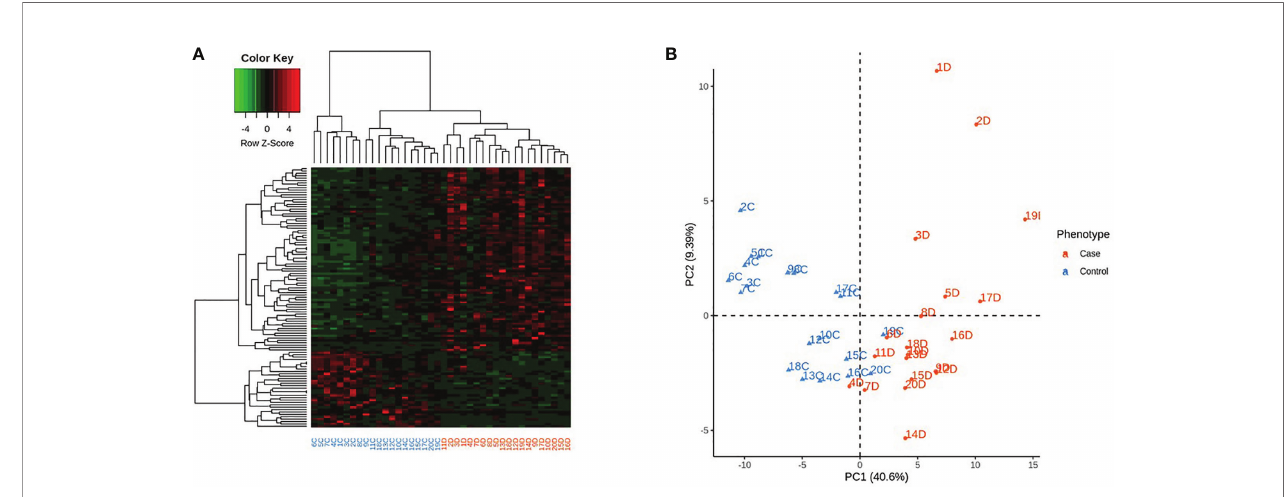
FIGURE 6 | Expression of the 105 differentially expressed Long non coding RNAs across the 40 samples, according to their phenotype. Control identi fi ers are written in blue, and case identi fi ers in orange. (A) Complete-linkage hierarchical clustering (HCA) based on spearman correlation. (B) First two components of principal component analysis